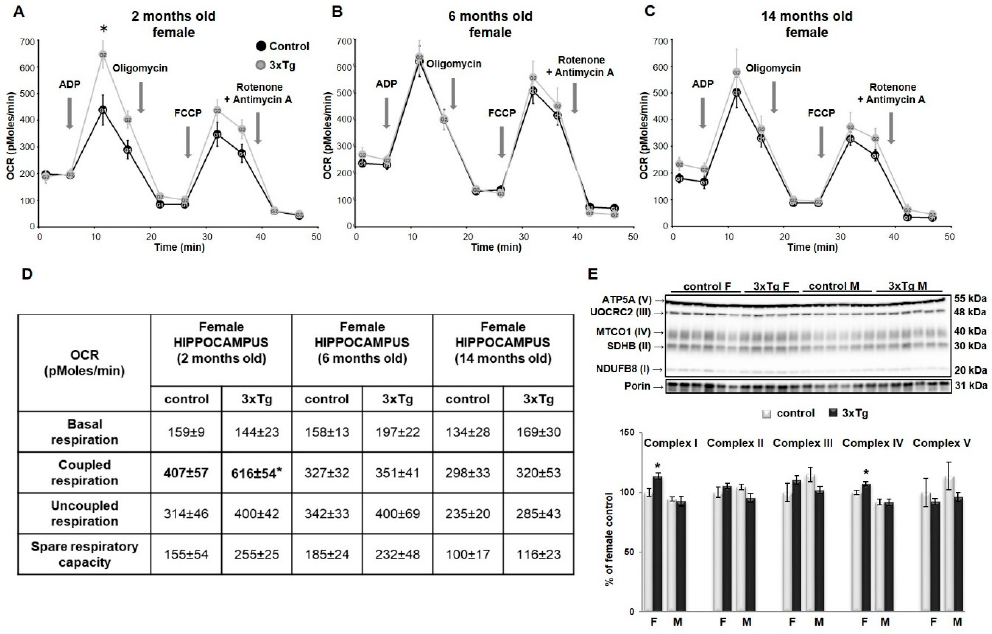
Figure 3. Representative measurements of oxygen consumption rates in mitochondria isolated from the hippocampus of 3xTg and age-matched control females at 2 months ( A ), 6 months ( B ) and 14 months of age ( C ). Coupled respiration (Table D , in bold) was significantly increased (* p < 0.05) only in 2 months old 3xTg female mice. No changes were detected in 3xTg males at any age. Data are expressed as OCR in pmoles / min, and values are expressed as mean ± SEM of n = 4–6 replicates. Representative WB ( E , upper panel) and relative quantification ( E , lower panel) for protein levels of OXPHOS subunits normalized to porin, in hippocampal mitochondria from 3xTg female and male mice and their respective controls at 2 months of age. Results are expressed as percent change from control mean of 100% ± SEM of n = 4–6 animals per group (* p < 0.05). No changes were detected in protein levels of OXPHOS subunits in hippocampal mitochondria from 3xTg mice at 6 and 14 months (data not shown).